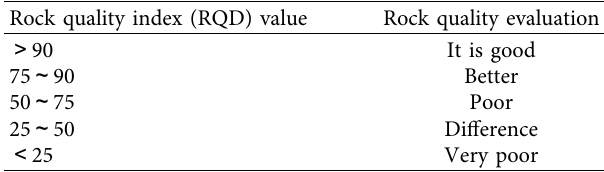
Table 4: Rock quality evaluation